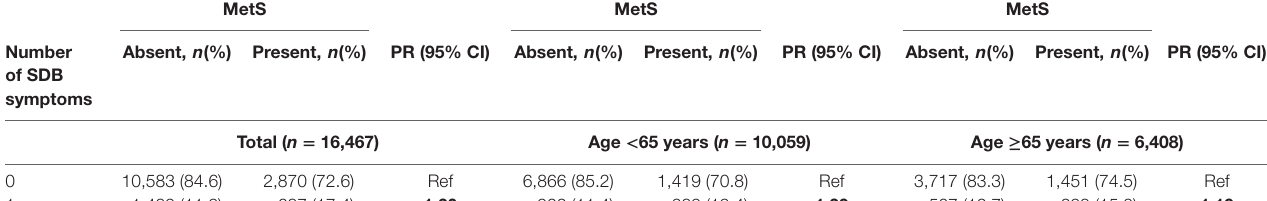
TaBle 4 | Association between the number of self-reported SDB symptoms and prevalence of MetS.